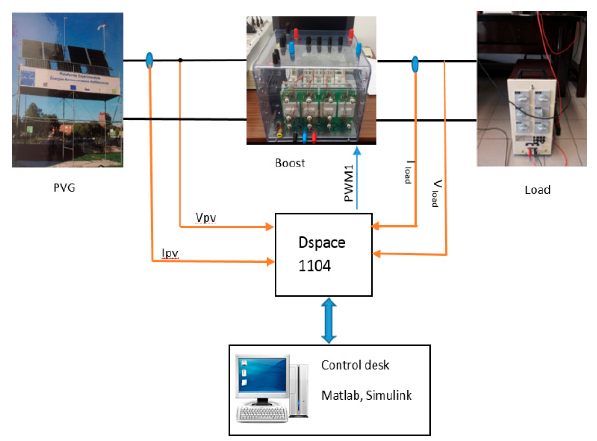
Figure 15. Schematic of the experimental setup for the conventional boost DC/DC converter.